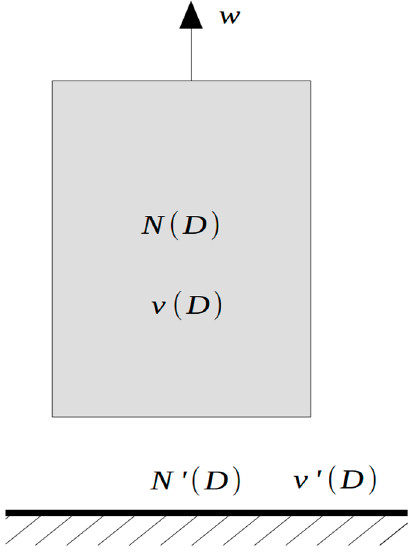
Figure 4. Model of falling rain in a moving vertical air column.